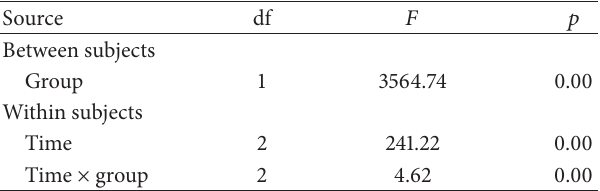
Table 7: Two-way repeated measures ANOVA analysis for the receptive posttests.